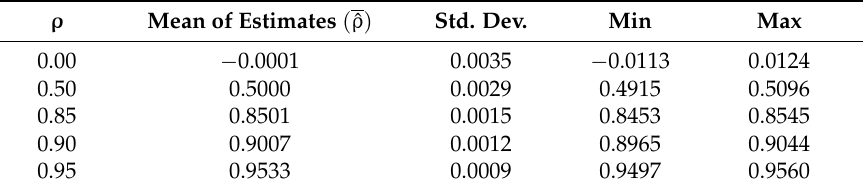
Table A2. Estimates of the spatial autocorrelation parameter ( ρ ) for selected high levels of spatial autocorrelation and a 400-by-400 tessellation based upon 1000 simulation replications and the standard normal